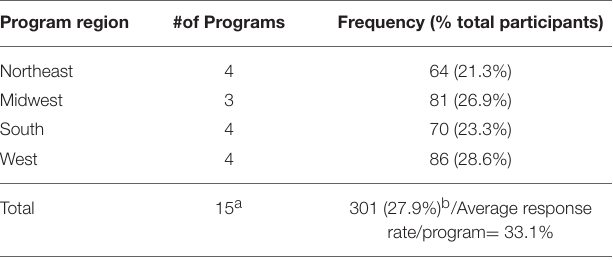
TABLE 3 | Resident parenting questionnaire participant geographic